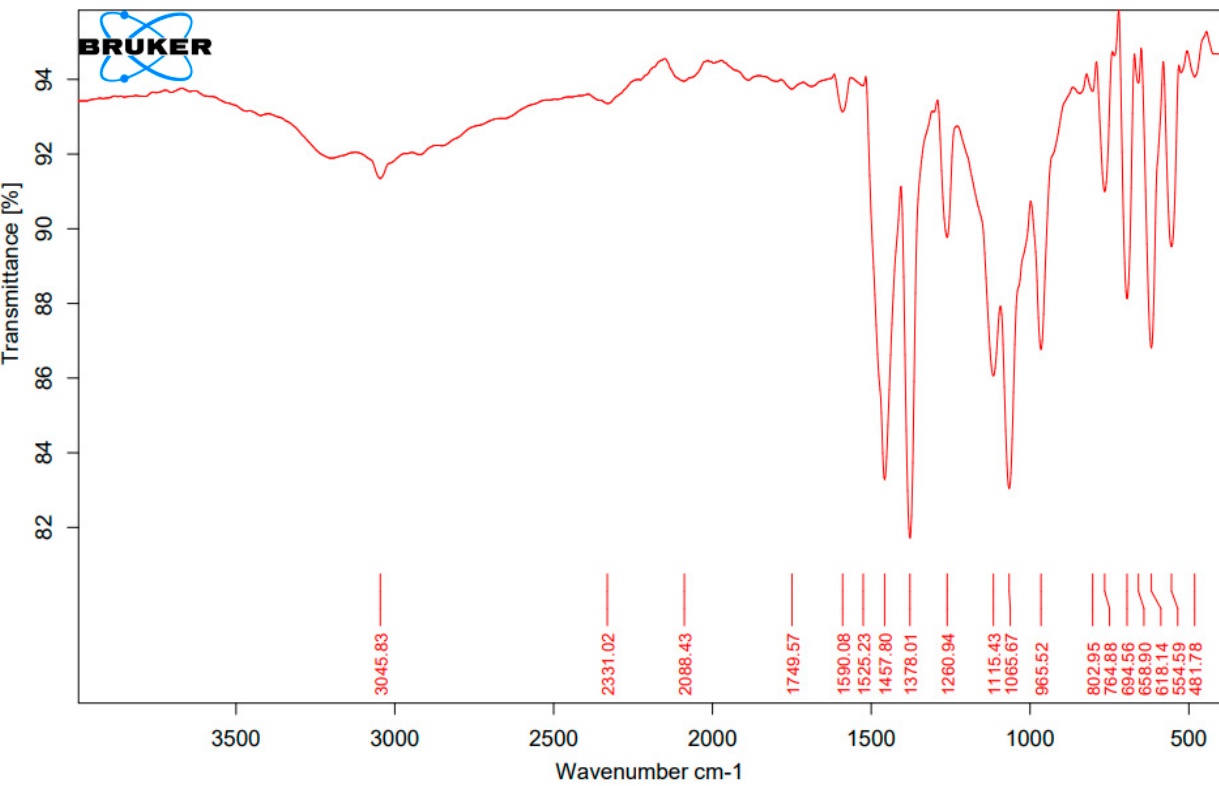
Figure 4. TIR spectra of indium(III)-tris( N -methyl- N -phenyl dithiocarbamate) complex .